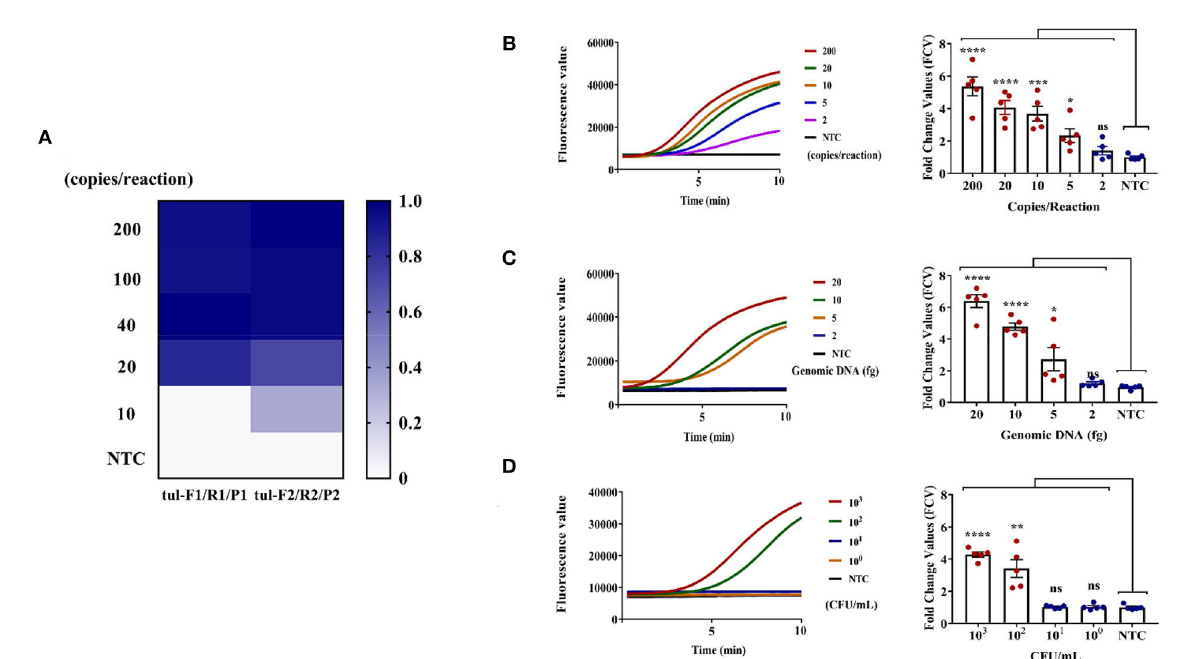
FIGURE2 RT-RPA assay for F. tularensis . (A) Screening optima RPA primers and probe under the same DNA template gradient concentration. (B) Sensitivity assessment using pEASY-T1-TUL4 plasmid (2 µ l of gradient concentrations of plasmid 100, 10, 5, 2.5, and 1 copies/ µ l), which can reach 5 copies/reaction, **** ( P < 0.0001), *** ( P = 0.0004), * ( P = 0.0145). (C) Sensitivity assessment using genomic DNA of F. tularensis (2 µ l of F. tularensis genomic DNA 10, 5, 2.5, and 1 fg/ µ l), which reaches 5 fg/reaction, **** ( P < 0.0001), * ( P = 0.0427), ns (non-significant). (D)